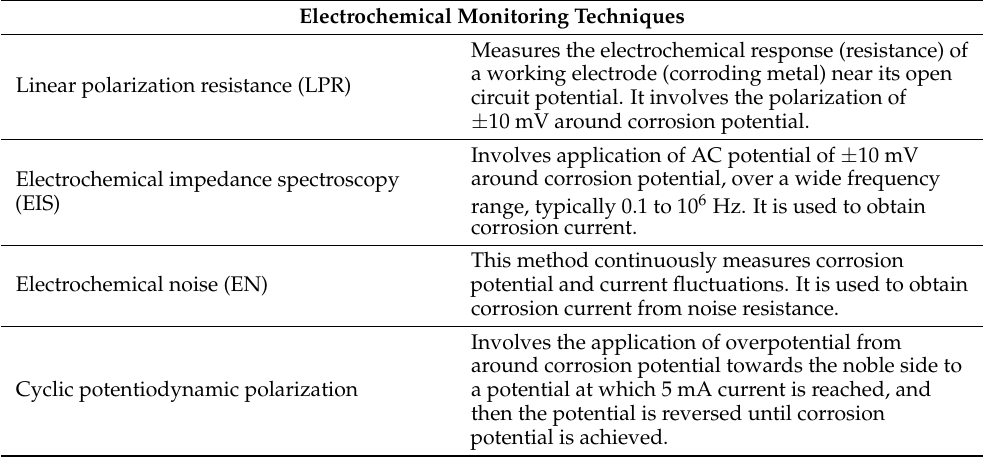
Table 3. Common electrochemical monitoring techniques. Data from [12,33,34].